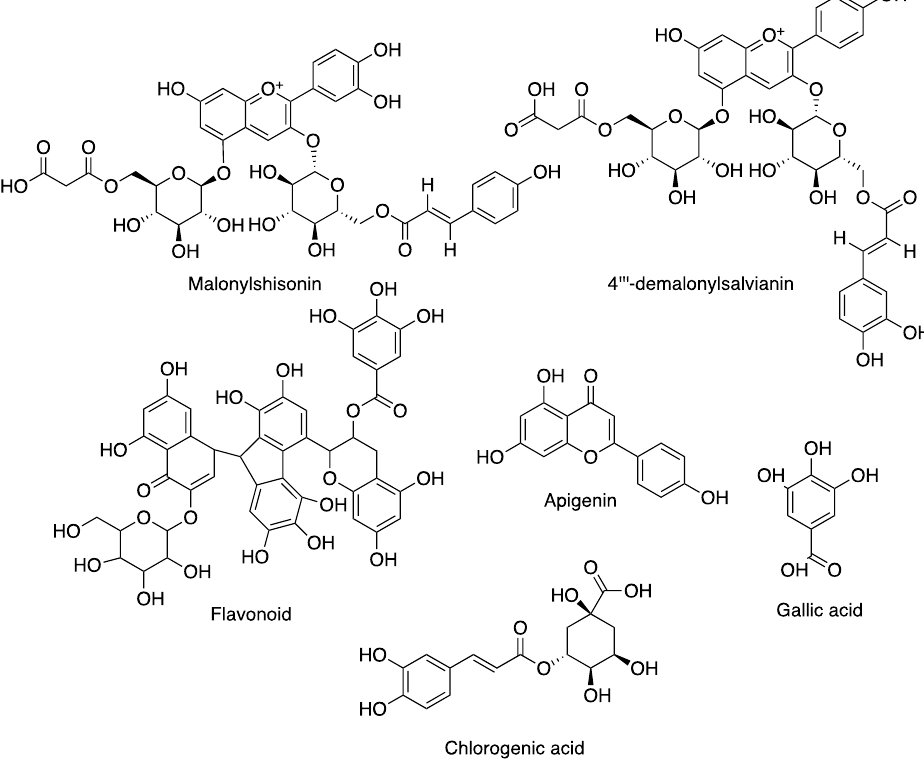
Figure 6. Structures of antiphotoaging compounds from red seaweeds. The biodiversity of seaweeds in Indonesia has not been fully explored and identified for economic value and utility in human life. In the survey on Indonesian seaweed biodiversity, we identified that red seaweeds might be potential MAAs-producing and antiphotoaging species. Red seaweeds were collected from the coastal area of Indonesia including Gunungkidul and Nusa Tenggara Timur [120,121]. The biodiversity of Indonesian red seaweeds is presented in Figure 7. The potential of Indonesian red seaweeds as sources of photoprotective and antiphotoaging compounds is compiled in